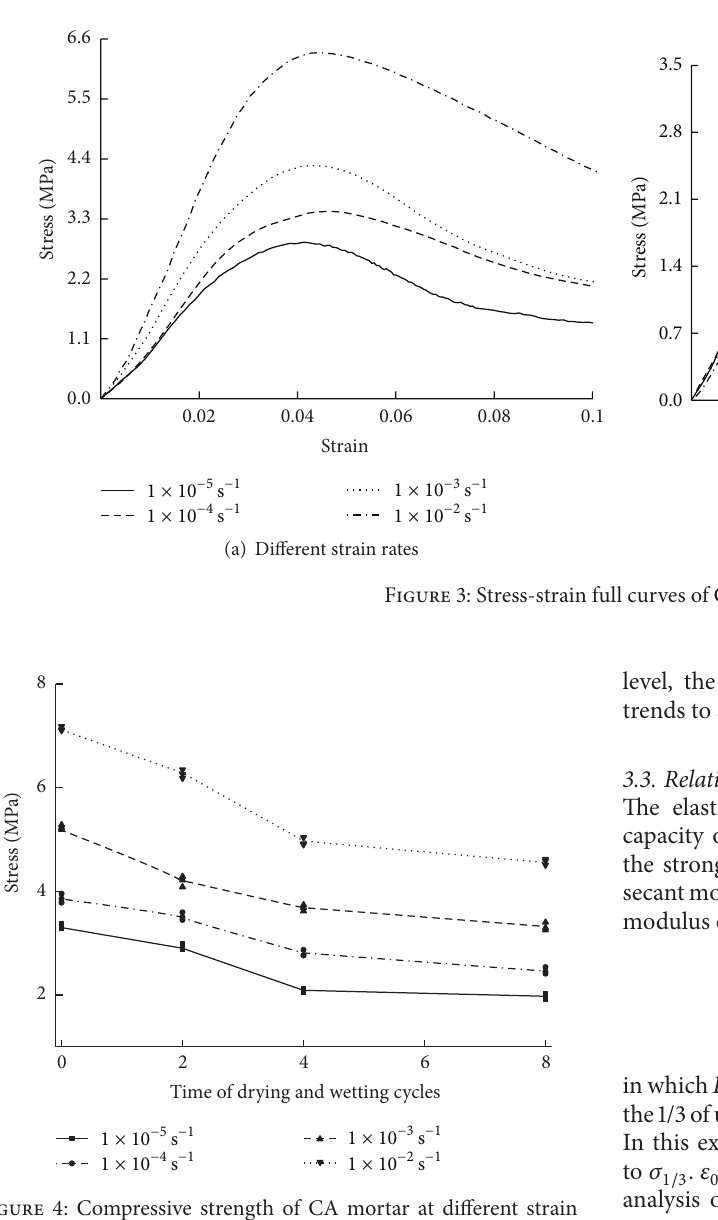
Figure 4: Compressive strength of CA mortar at different strain rates and drying and wetting cycle